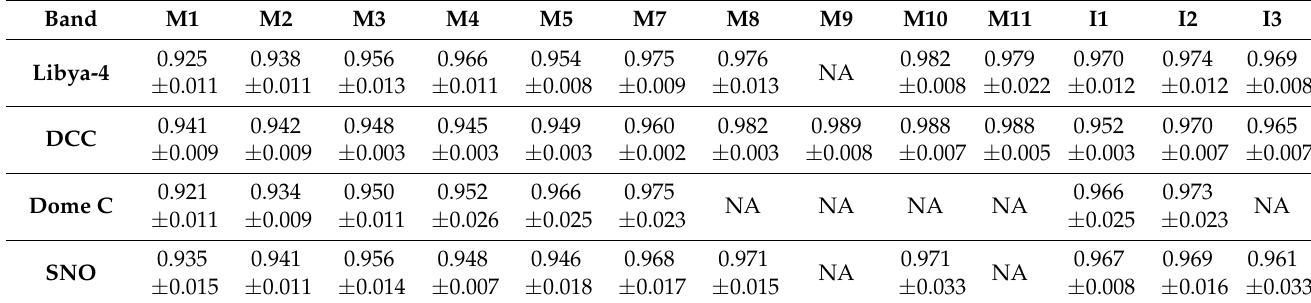
Table 6. SNPP and NOAA20 VIIRS RSB comparison. Results are provided in ratio (NOAA20/SNPP). Values in bracket parentheses are the standard error. Those marked “NA” are either not applicable or are excluded due to data